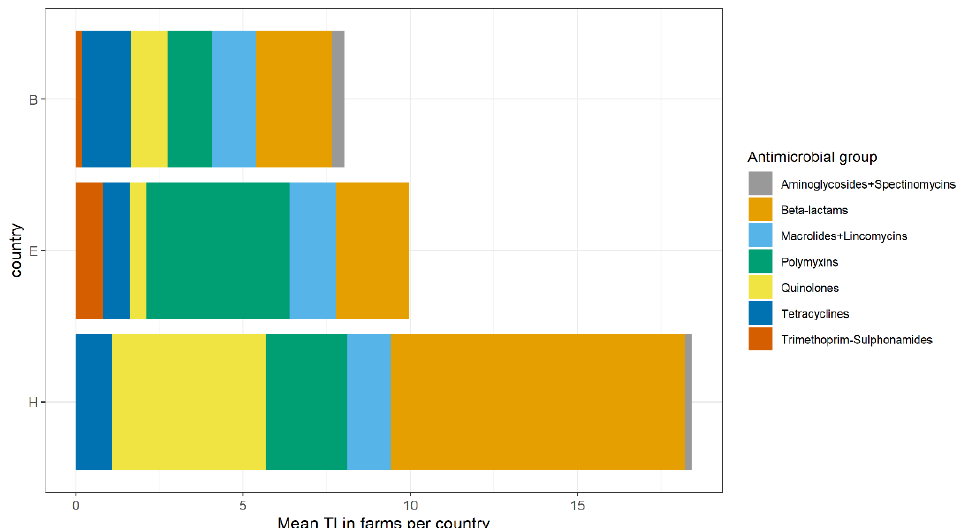
Figure 1. Average antimicrobial usage on farm level in 60 turkey farms in three countries. Mean treatment incidence (TI) shows the average number of treatment days per 100 days. Antimicrobials were grouped after TI was calculated for lincomycin-spectinomycin combination product and subsequently divided and added to macrolides and aminoglycosides, respectively. Beta-lactams included aminopenicillins and penicillins. Quinolones included fluoroquinolones and other quinolones (flumequine). Countries were anonymized as B, E, and H.